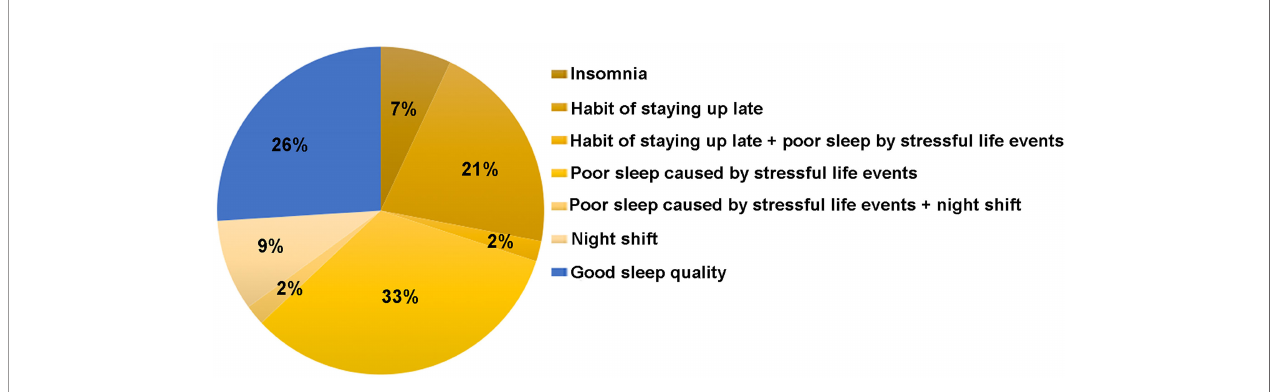
FIGURE 2 | Distribution of sleep status among participants (n =